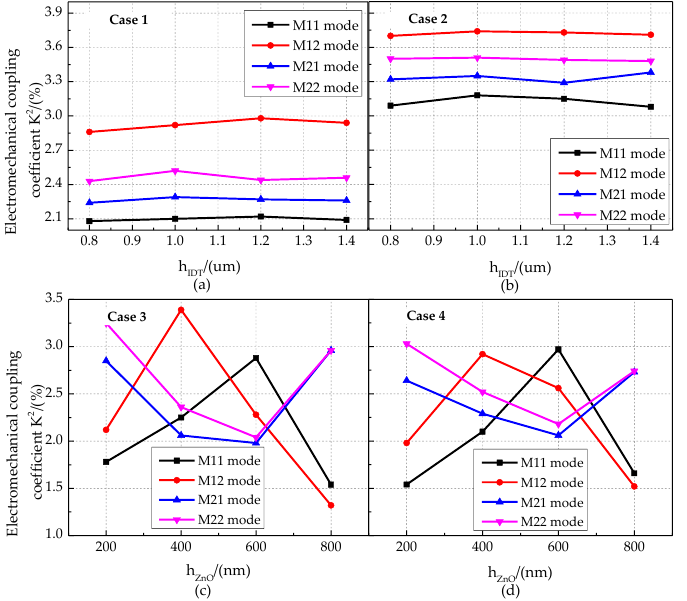
Figure 15. Electromechanical coupling coefficient K 2 for different cases. ( a ) Case 1. ( b ) Case 2. ( c ) Case 3. ( d ) Case 4.